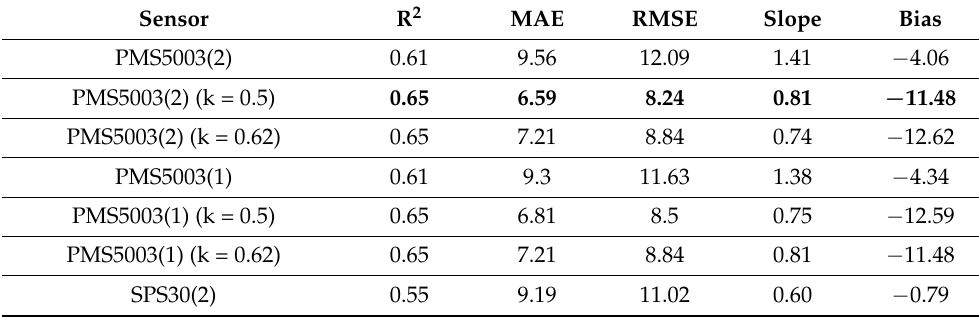
Table 5. The performance indicators of the sensors under evaluation. The rows indicating PMS5003(1), PMS5003(2), and so on, show the data related to the uncorrected measurements, while the labels k = 0.5 and k = 0.62 indicate the data calculated by setting k = 0.5 and k = 0.62 in Equation (7). Data reported in bold characters denote the best